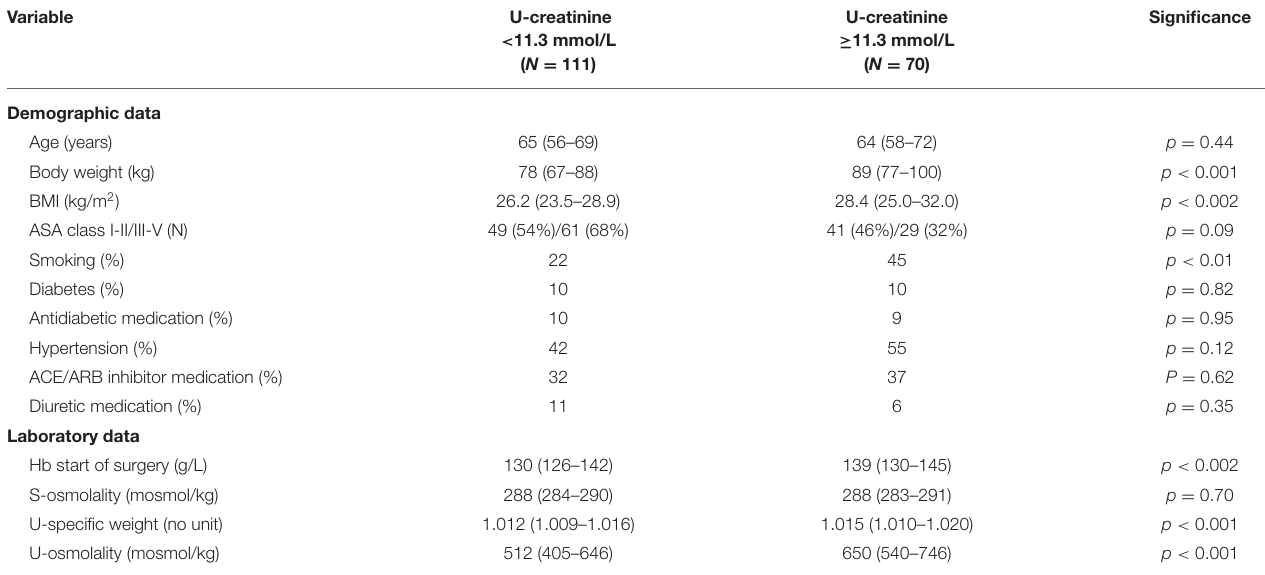
TABLE 1 | Demographic data and biochemistry before surgery.